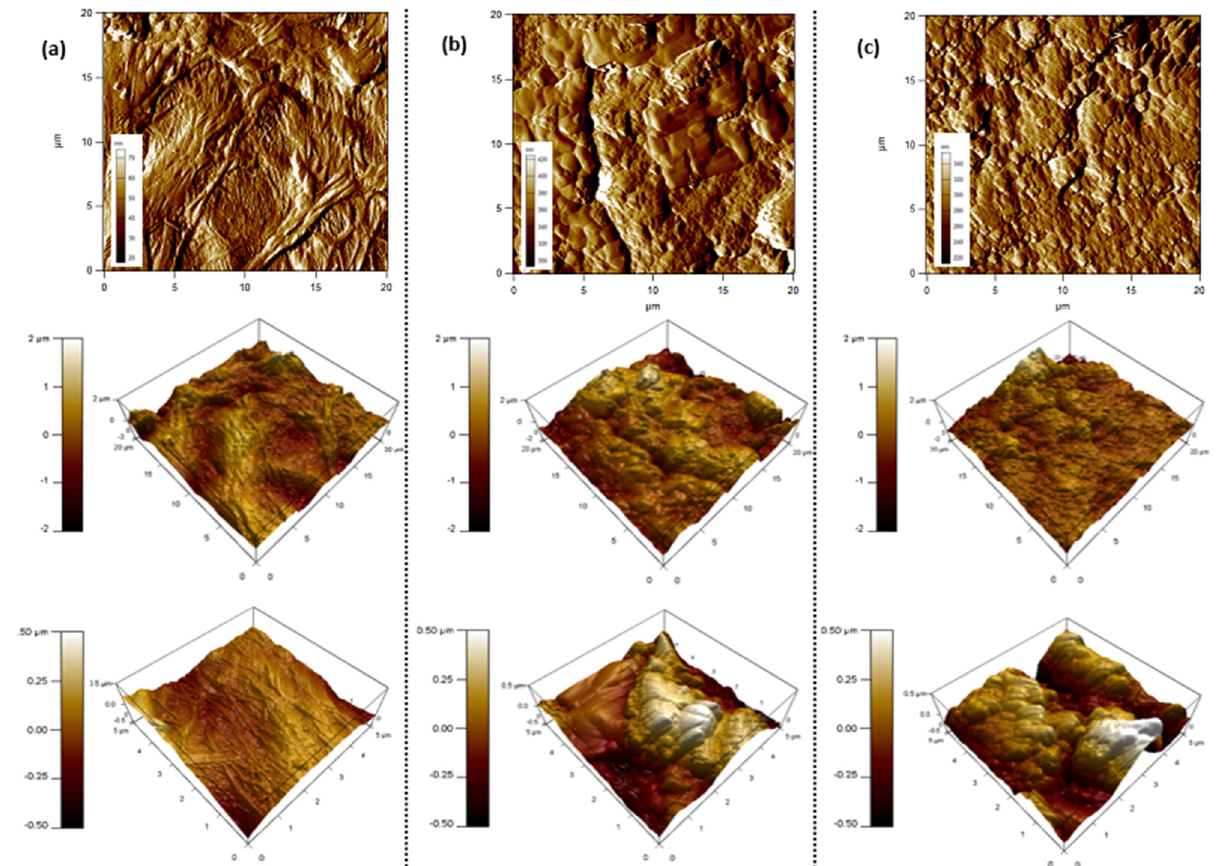
Figure 5. AFM images for PE membranes ( a ) before, ( b ) after 40 h, and ( c ) after 100 h of pilot-scale DCMD tests.